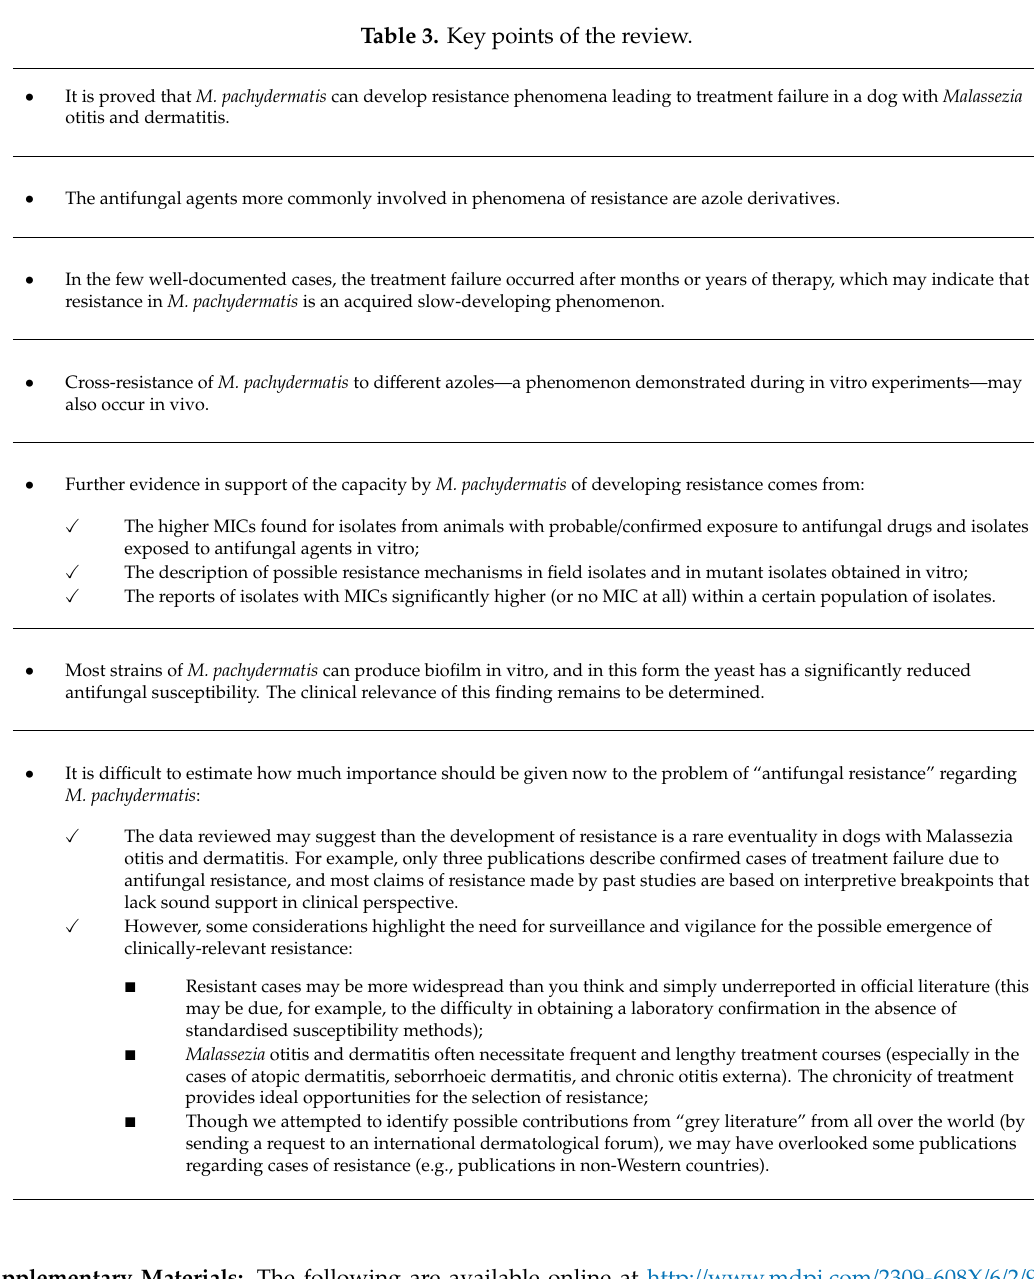
Table 3. Key points of the